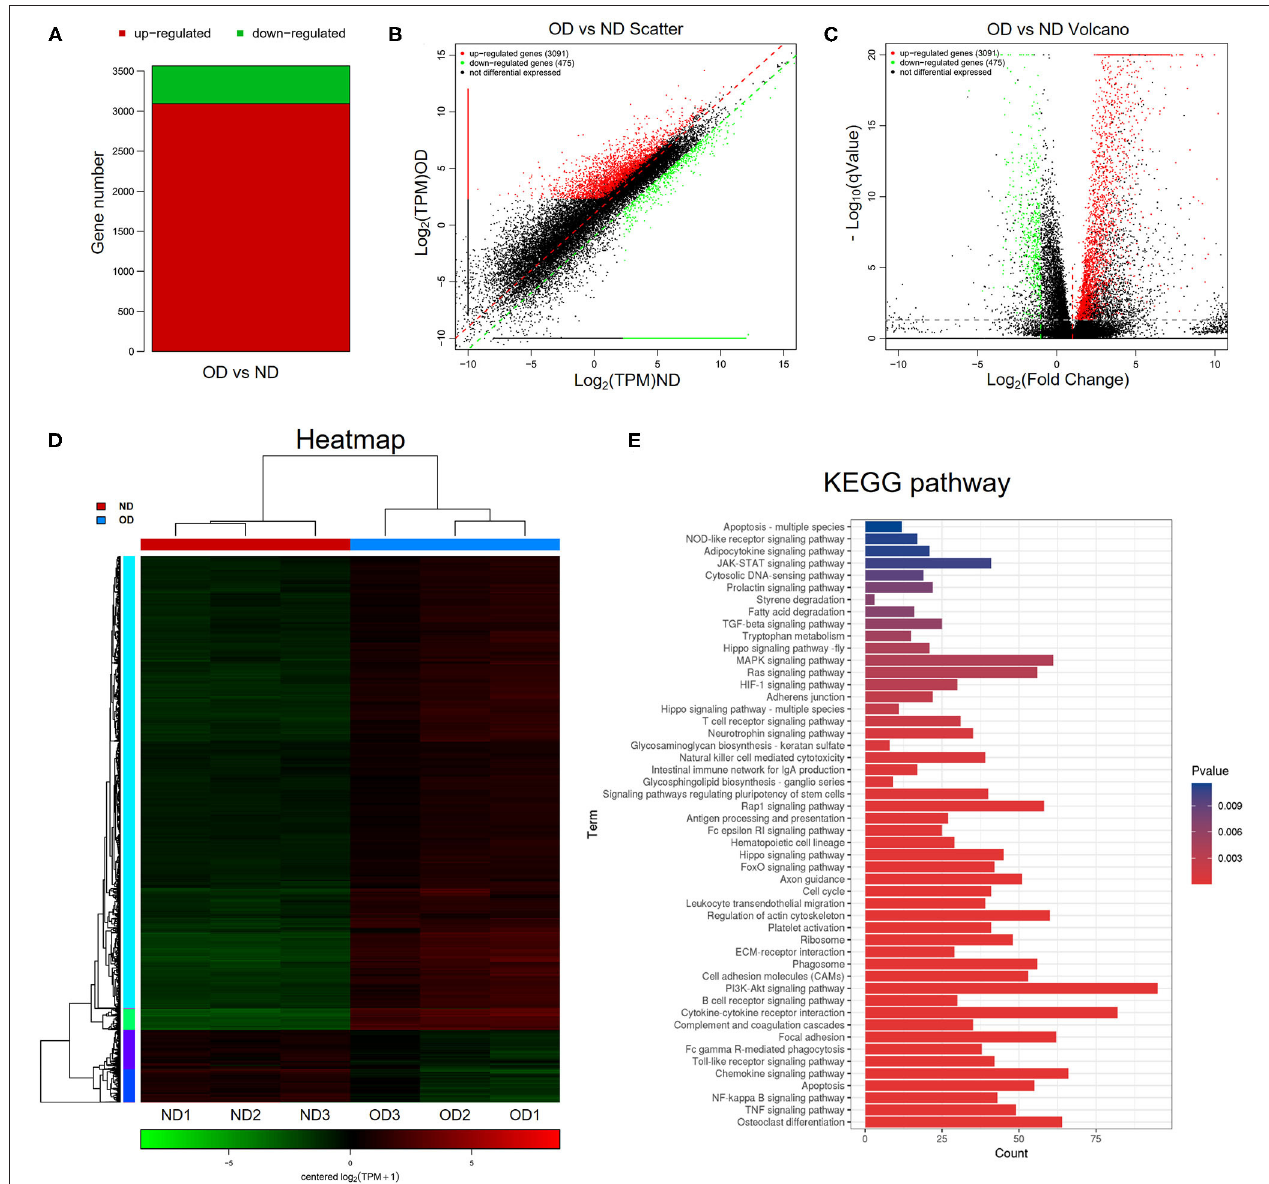
FIGURE 4 | RNA-seq analysis and KEGG pathway analysis. (A–C) Histogram, scatter plot and volcano plot of DEGs between the OD and ND groups identified by differential expression analysis. (D) Heatmap and hierarchical clustering showing different gene expression patterns between the OD and ND groups. (E) The top 50 enriched KEGG pathways analysis of the identified